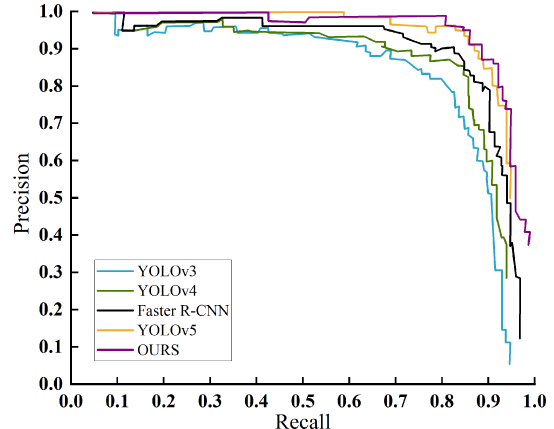
Figure 14. P – R curves of different